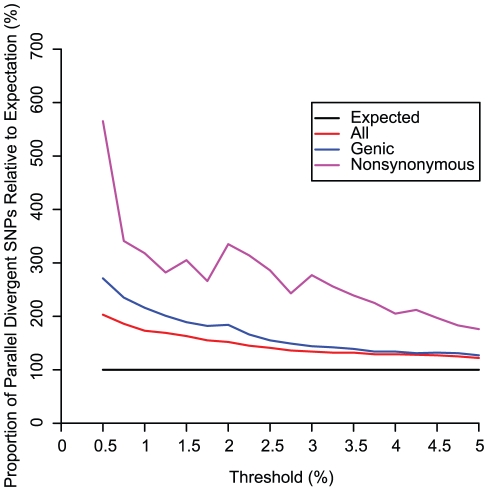
Relative proportions of SNP classes across various thresholds.Relative proportion of parallel divergent SNPs, genic parallel divergent SNPs, and nonsynonymous parallel divergent SNPs are shown for thresholds less than or equal to 5%. All thresholds show an excess of parallel divergent SNPs that is more pronounced for genic SNPs and even more pronounced for nonsynonymous SNPs. As the threshold is lowered, the relative proportion of genic and nonsynonymous SNPs increases faster than for all SNPs combined, suggesting that positive selection is driving the pattern.